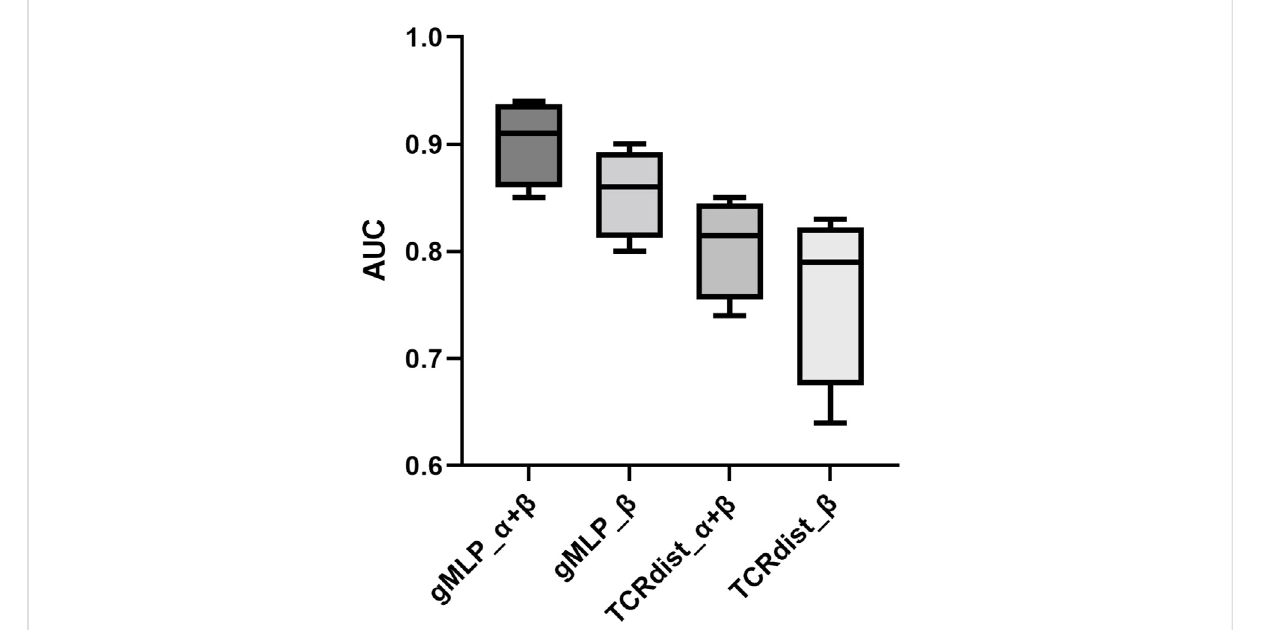
FIGURE 6 Performance evaluation of gMLP and TCRdist on the IEDB 95% threshold